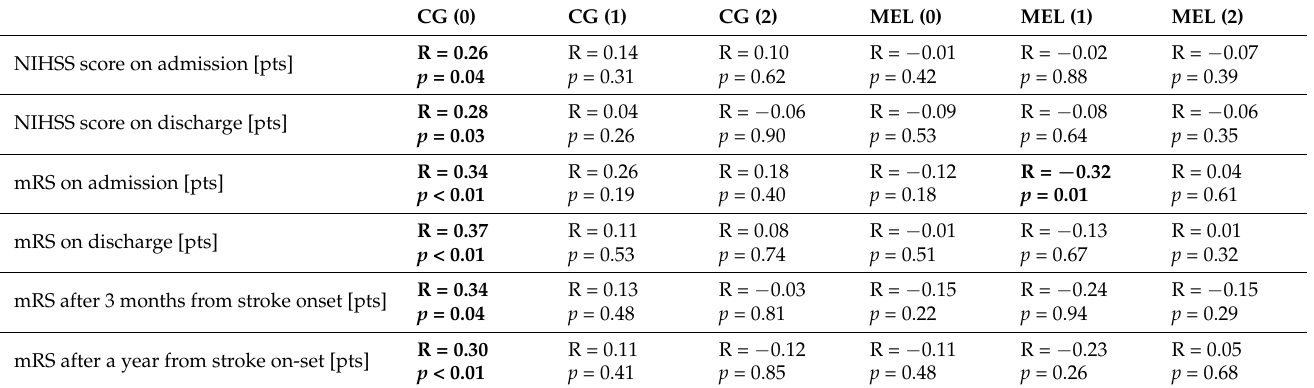
Table 4. Statistical correlation between the concentration of biomarkers at different time points and the severity of neurological symptoms on admission/discharge and functional outcomes at 3 months and one year after the onset of stroke.